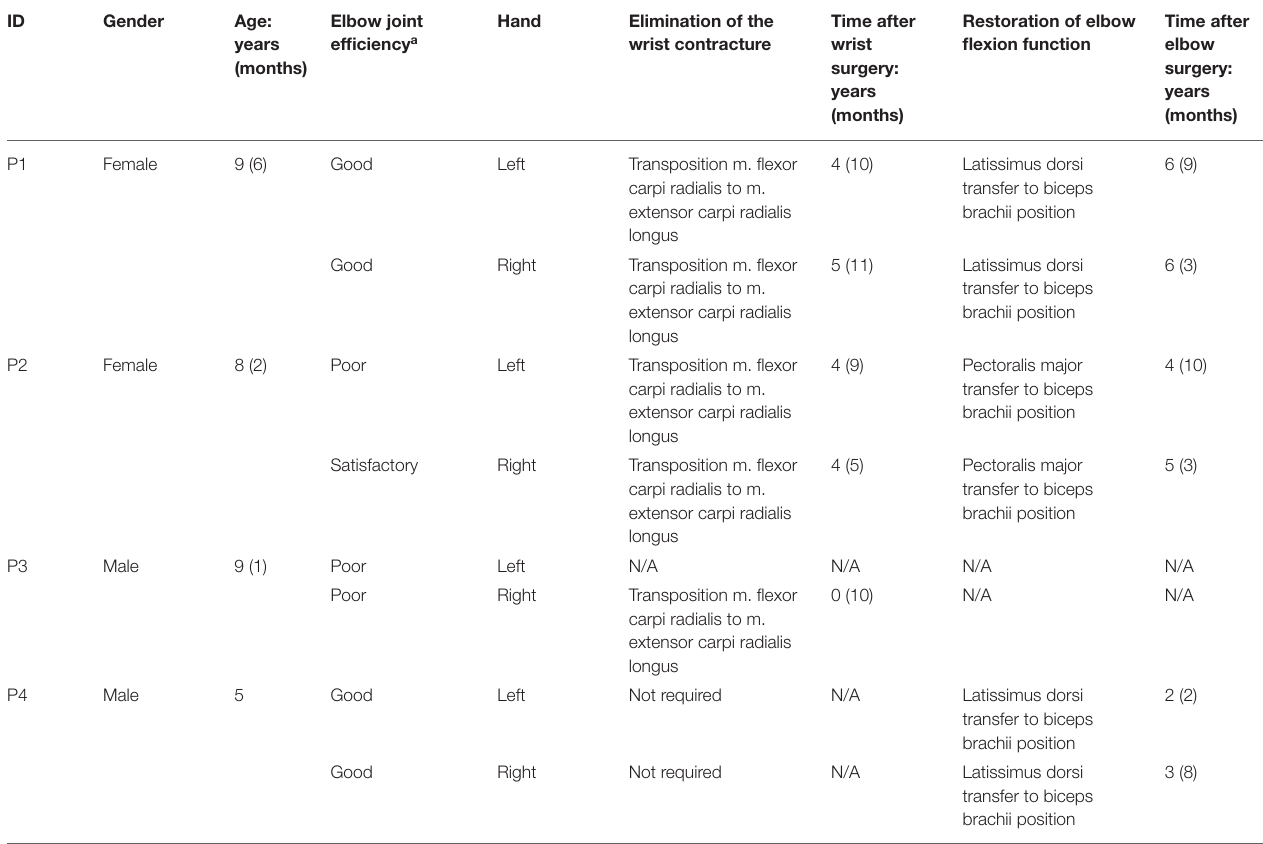
TABLE 1 | Demographic information and clinical history of